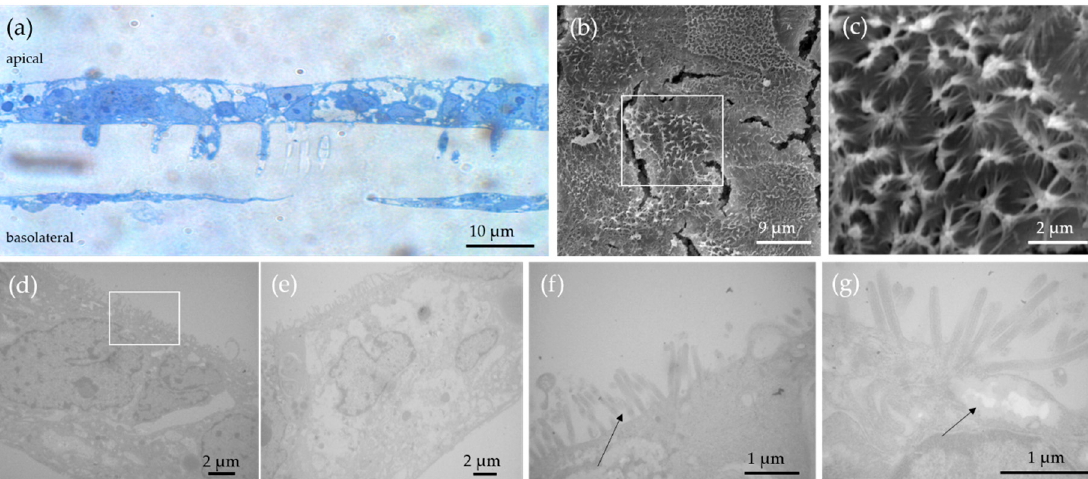
Figure 3. TEM images of the gastrointestinal in vitro model. The different intestinal cell types of the triple co-culture (Caco-2 cells, HT29-MTX-E12 cells and THP-1 cells) after 21 days of cultivation could be identified. ( a ) Light microscopic images of HE stained GI co-triple-culture. Caco-2 and HT29-MTX-E12 cells are cultured on the apical side of the membrane of the cell culture insert, THP-1 cells on the basolateral side. ( b ) SEM image of the surface of the GI triple co-culture. ( c ) Enlargement of the SEM image marked in ( b ) showing the microvilli of the Caco-2 cells. ( d , e ) TEM image of the GI triple co-culture. ( f ) TEM image of the GI triple co-culture. Black arrows indicate the microvilli. ( g ) TEM image of the GI triple co-culture. Black arrows indicate the encapsulated mucus which is secreted by the HT29-MTX-E12 cells.